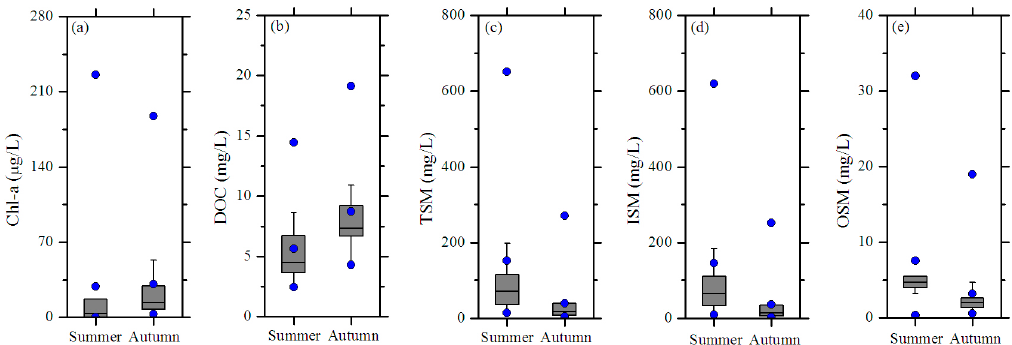
Figure 2. Box plots of dissolved carbon, total suspended matter and chlorophyll ‐ a in the watershed, Yitong River, Yinma River and STKM Reservoir: ( a ) Chlorophyll ‐ a concentration ( μ g/L) (F = 0.015, p > 0.05); ( b ) DOC concentration (mg/L) (F = 6.4, p < 0.05); ( c ) Total suspended matter (mg/L) (F = 5.4, p < 0.05); ( d ) Inorganic suspended matter (mg/L) (F = 5.5, p < 0.05); and ( e ) Organic suspended matter (F = 3.7, p > 0.05). The horizontal edges of the boxes denote the 25th and 75th percentiles; the whiskers denote the 10th and 90th percentiles, and the blue circles represent outliers.